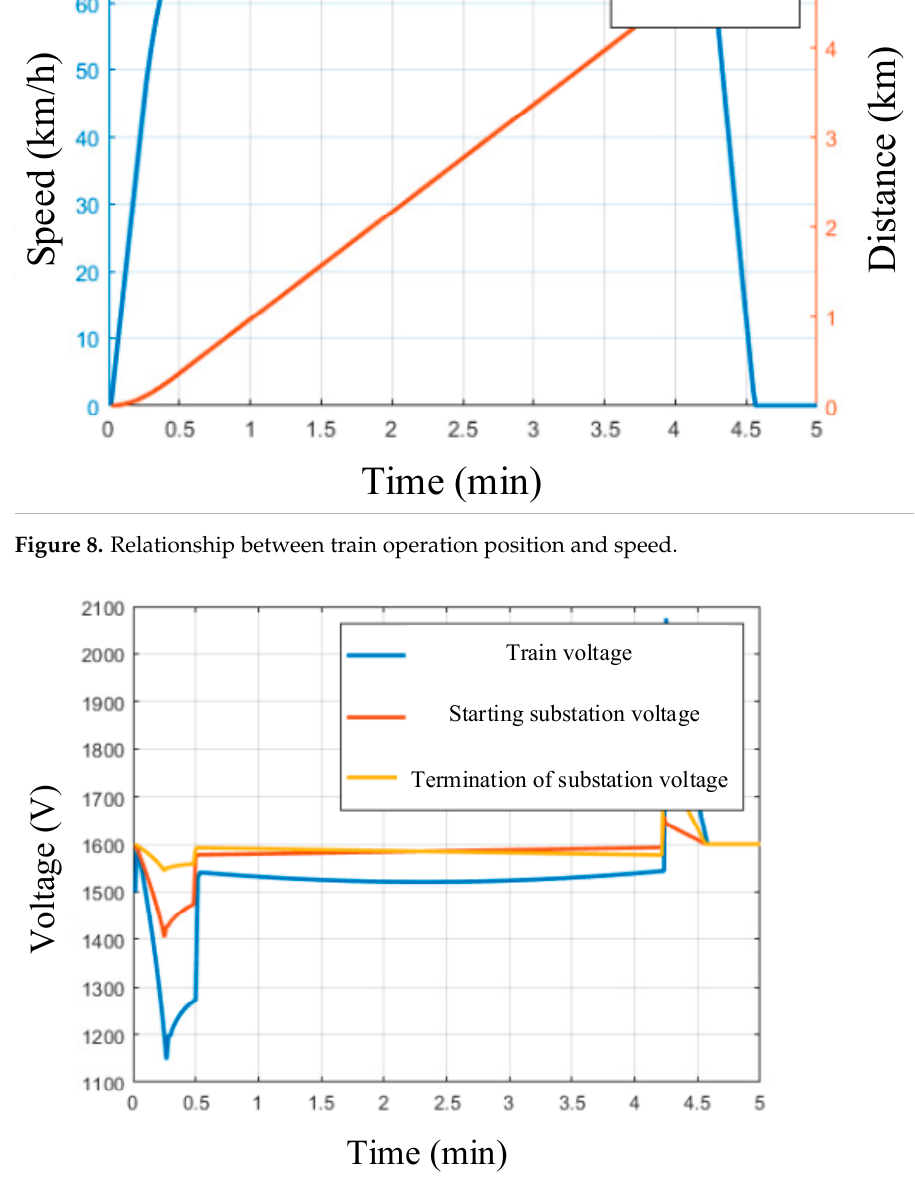
Figure 9. Voltage variation diagram of substation and train.